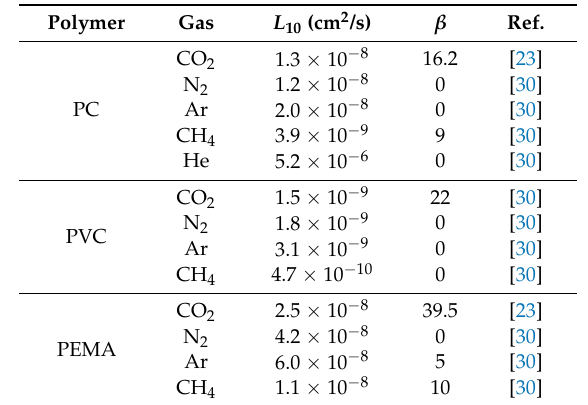
Table 3. Parameters of the STM-GP model: infinite dilution mobility coefficient L 10 and plasticization factor β .